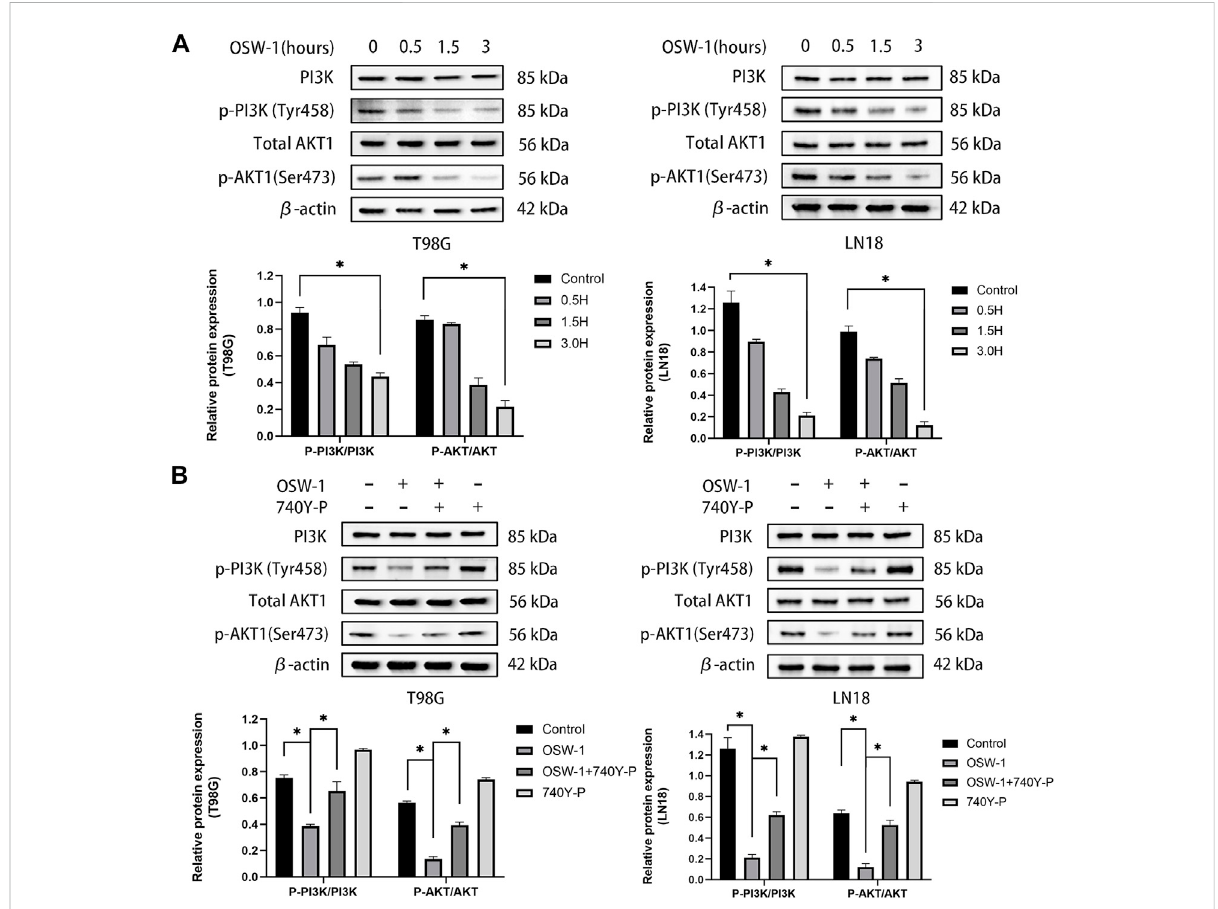
FIGURE 7 Theinhibitoryeffects ofOSW-1 onthePI3K/AKT signaling pathway inglioma cellscan bereversedby 740Y-P (A) Westernblotof AKT1,p-AKT1, PI3K, and p-PI3K in glioma cells treated with OSW-1 (10 nM) for different hours. OSW-1 signi fi cantly reduced the expression levels of p-Akt and p-PI3Kat3 h (B) WesternblotofAKT1,p-AKT1,PI3K,andp-PI3KingliomacellstreatedwithOSW-1(10 nM),740Y-P(15 µM),OSW-1(10 nM)+740Y-P (15 µM)orcontrolsfor3 h.Theexpressionlevelsofp-Aktandp-PI3Kweresigni fi cantlyhigherintheOSW-1+740Y-P-treatedgroupcompared with the OSW-1-treated group. * p < 0.05, compared to the control